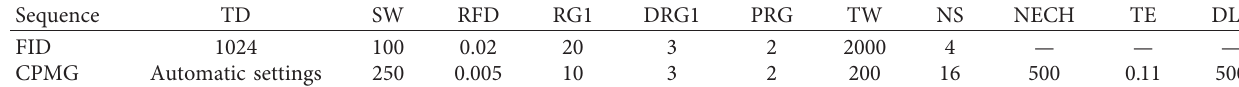
Table 3: Parameter settings for LF-NMR.